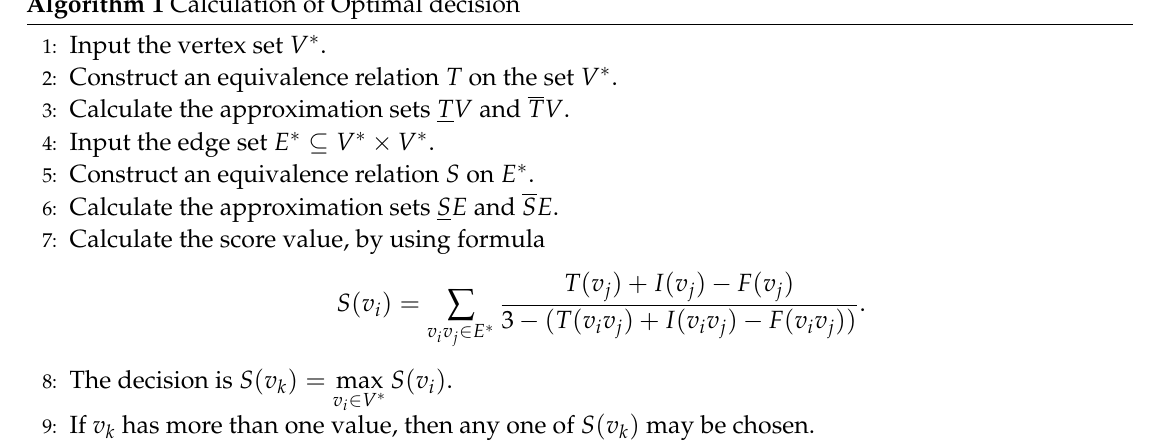
Algorithm 1 Calculation of Optimal